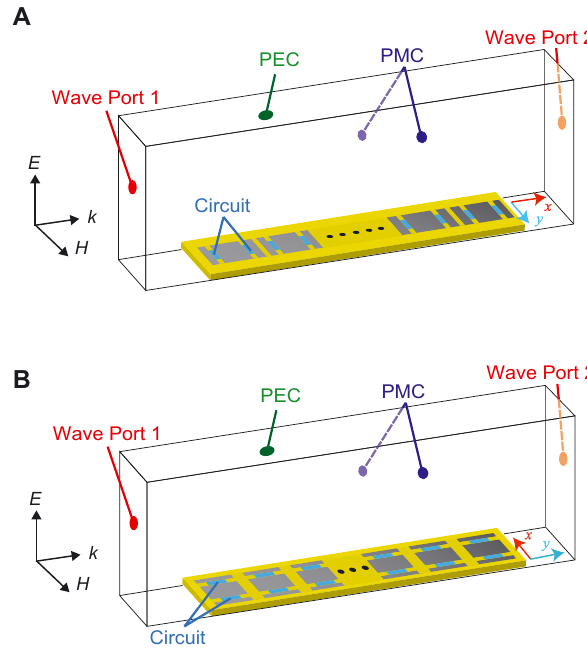
Figure 5: Surface wave propagation in a 1D model along two orthogonal directions: (A) x -direction and (B) y -direction. The lowest mode is excited by wave port 1, where the electric field is vertically polarized as drawn by the arrows of E . This mode effectively behaves as the lowest TM mode around the metasurface. The gaps between the metasurface and the wave ports are twice the periodicity (30 mm), which are larger than the quarter wavelength of 3.0 GHz (25